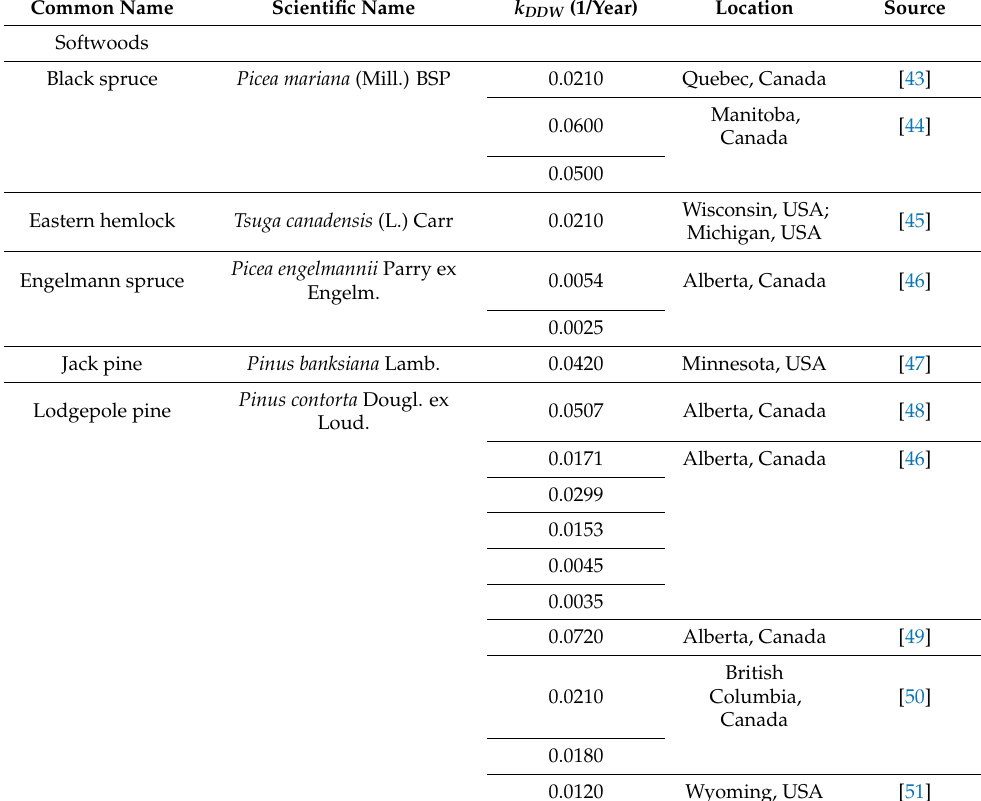
Table 2. Estimated decay rates of down dead wood ( k DDW ) in North American boreal forests. Multiple values for a species reported by a single source reflect either different methods of estimation or multiple sites included in the